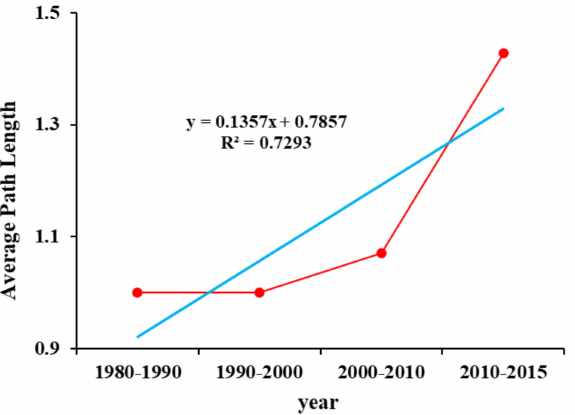
Figure 7. Changes of the average shortest path of transfer matrix networks in study areas